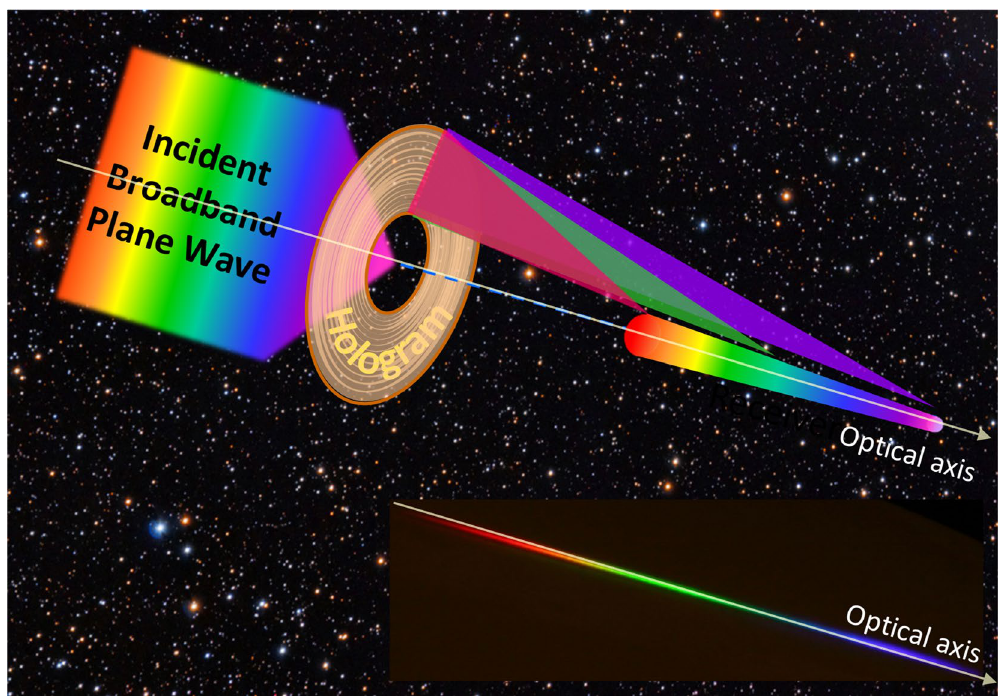
Figure 1. A schematic diagram of the dual use exoplanet telescope (DUET) based on a Fresnel hologram. (Inset) The photo shows a diffracted image of sunlight when passing through a Fresnel